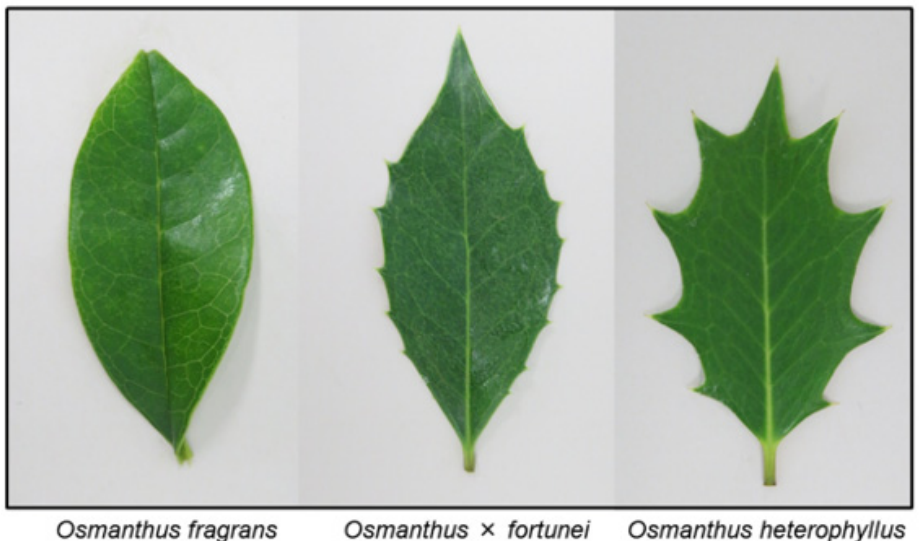
Figure 1. The leaves of O. fragrans, O. × fortunei, and O. heterophyllus.